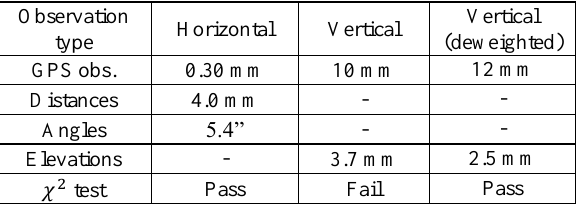
Table 2. RMSE of residuals of observations after WLS adjustments. The deweighted vertical adjustment indicates that the a priori standard deviations of the OPUS-Projects elevations were increased, thus given less weight.